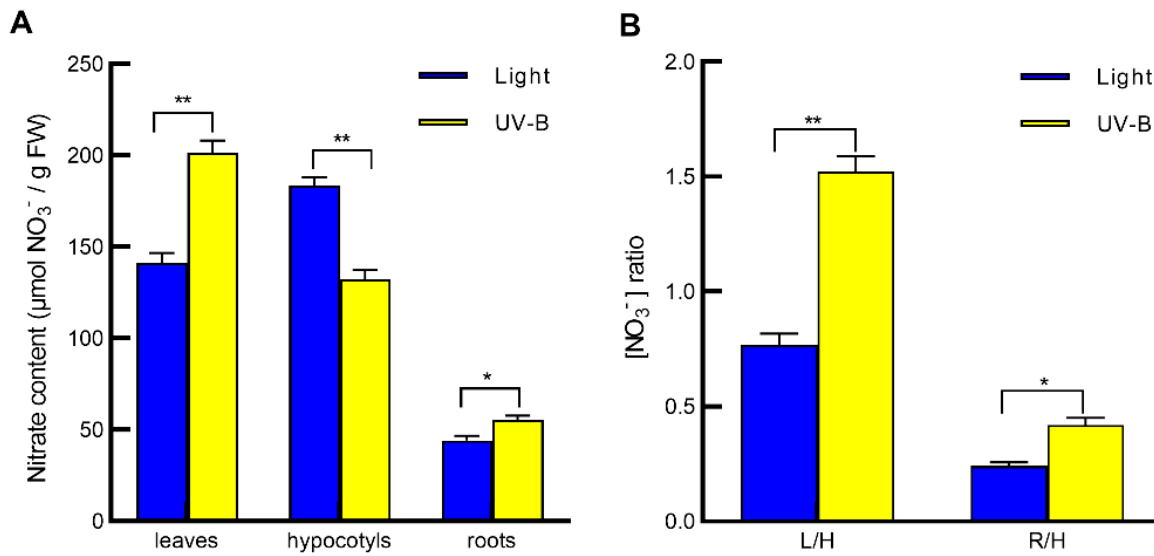
Figure 1. UV-B-induced nitrate reallocation from hypocotyls to leaves and roots. Twenty-day-old seedlings of Arabidopsis wild-type Col-0 grown in vermiculite substrate were exposed to light alone (Light) or with 0.5 W/m 2 UV-B (UV-B) for 3 h. Then, leaves, hypocotyls and roots were harvested, their nitrate contents were determined ( A ), and the leaf/hypocotyl (L/H) and root/hypocotyl (R/H) nitrate ratios were calculated ( B ). Values are means ± SE of three biological replicates, each pooled more than thirty plants. Asterisks indicate significant differences between light and UV-B treatments (* p < 0.05; ** p < 0.01).